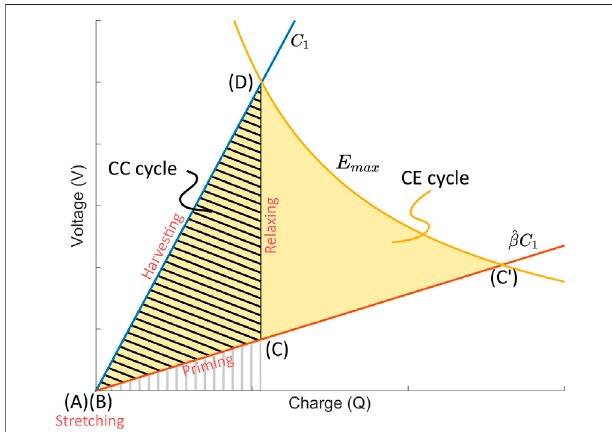
FIGURE 1 | Constant charge (CC) and Constant fi eld (CE) harvesting cycle in the Q-V plane of a DEG which is stretched from a capacitance C 1 to ^ β C 1 and relaxed back to C 1 . The grey hatched area with vertical stripes represents the amount of input energy required to prime the generator fortheCCcycle.Incontrast,theblackhatchedarearepresentsthenetenergy gain per cycle. The yellow area represents the net energy gain per cycle in the caseofaconstant fi eld(CE)cycle,fora fi eldvalueequaltothemaximalelectric fi eld E max